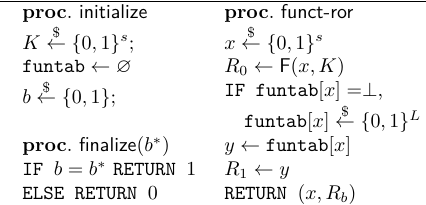
Figure 26: Procedures in Security Game WPRF